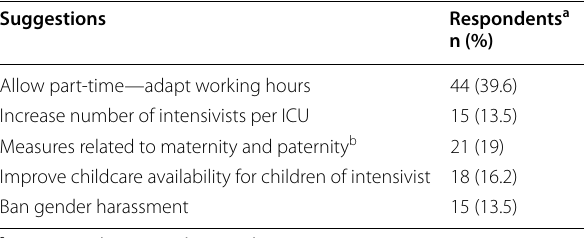
Table 6 Top 5 of the suggestions made by 111 women intensivists to improve their work